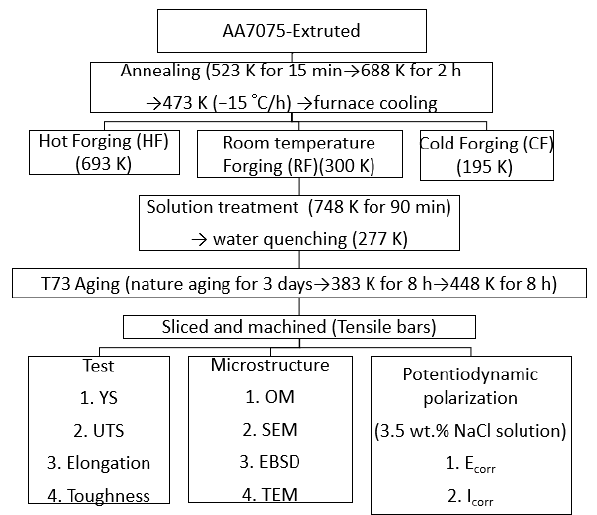
Figure 2. A flow chart used for explaining the experiment and tests.